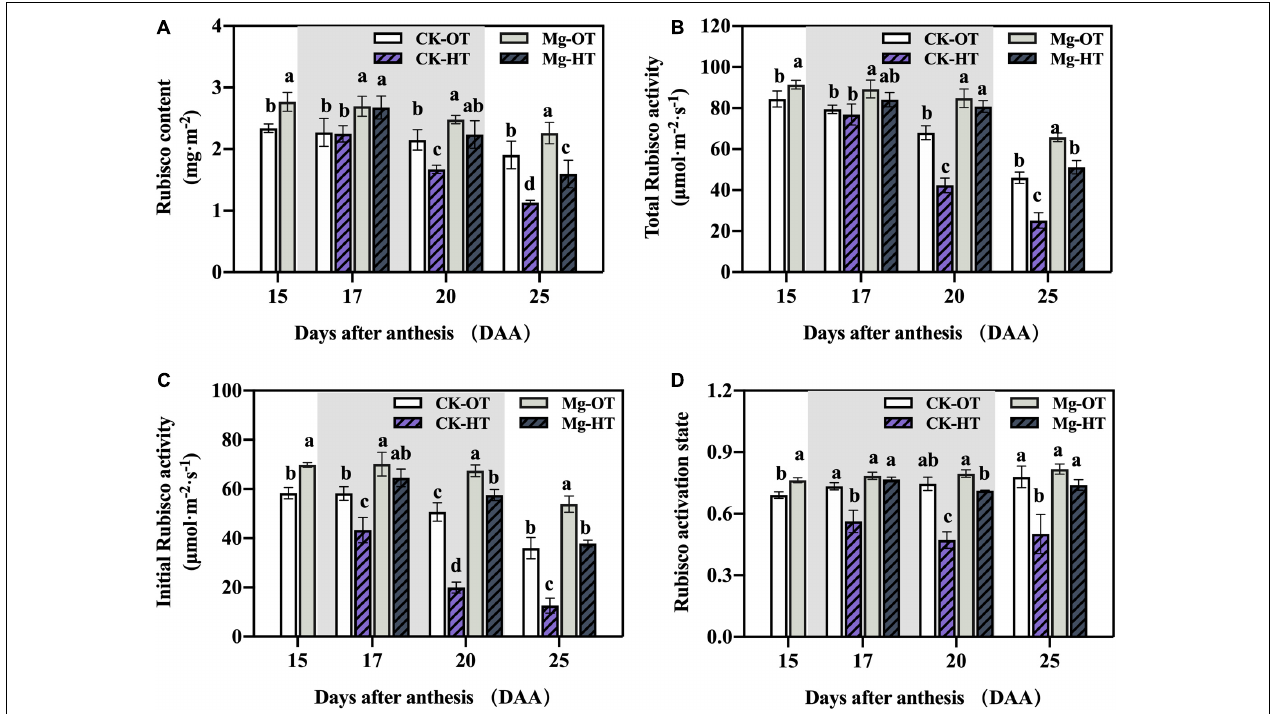
FIGURE 3 | Effect of Mg application on Rubisco content and activity under HTS during the grain filling stage. Two-way analysis of variance was performed; each bar is the mean ± SE of five replications. Different lowercase letters indicate significant variations within the same day at P < 0.5 (Duncan’s multiple-comparison tests).